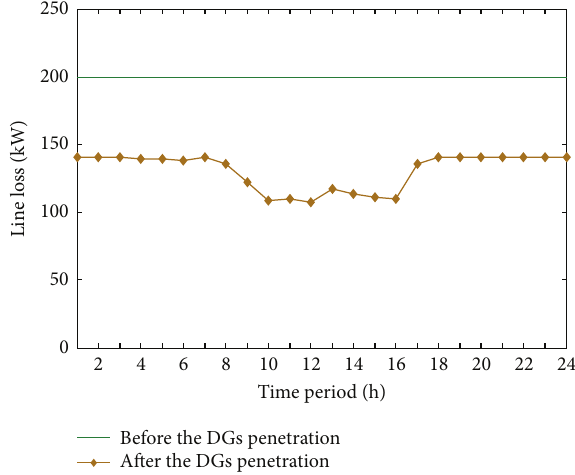
Figure 5: The power system loss before and after DG unit